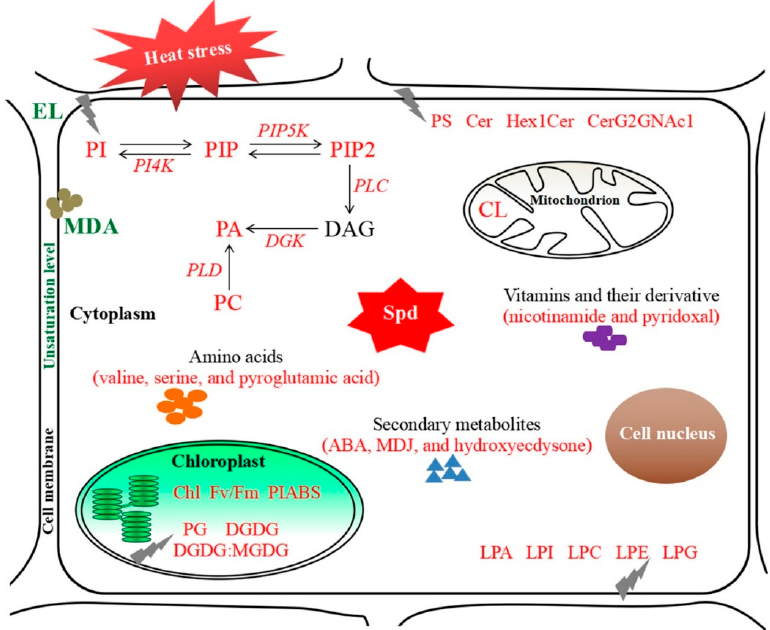
Figure 10. Regulatory pathways induced by the spermidine associated with alterations in metabolic homeostasis, lipids signaling, and lipidomic remodeling in plants under heat stress. Red or green characters indicate significant increases or decreases induced by spermidine under heat stress, respectively.